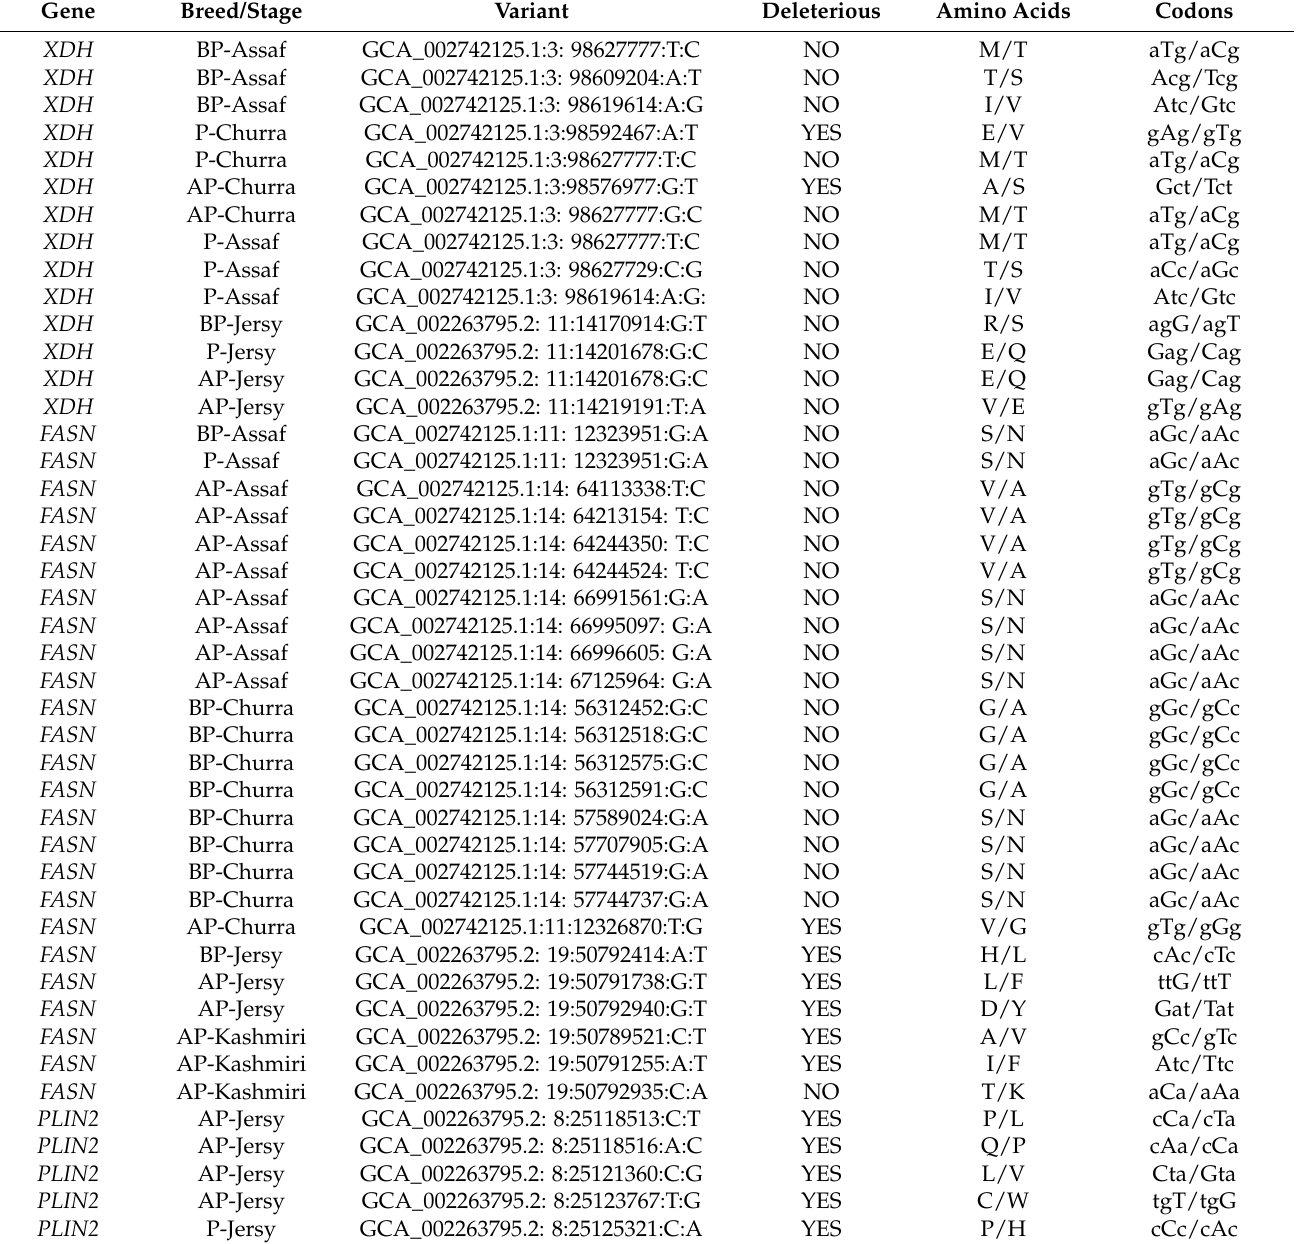
Table 8. Novel missense variants in major milk fat